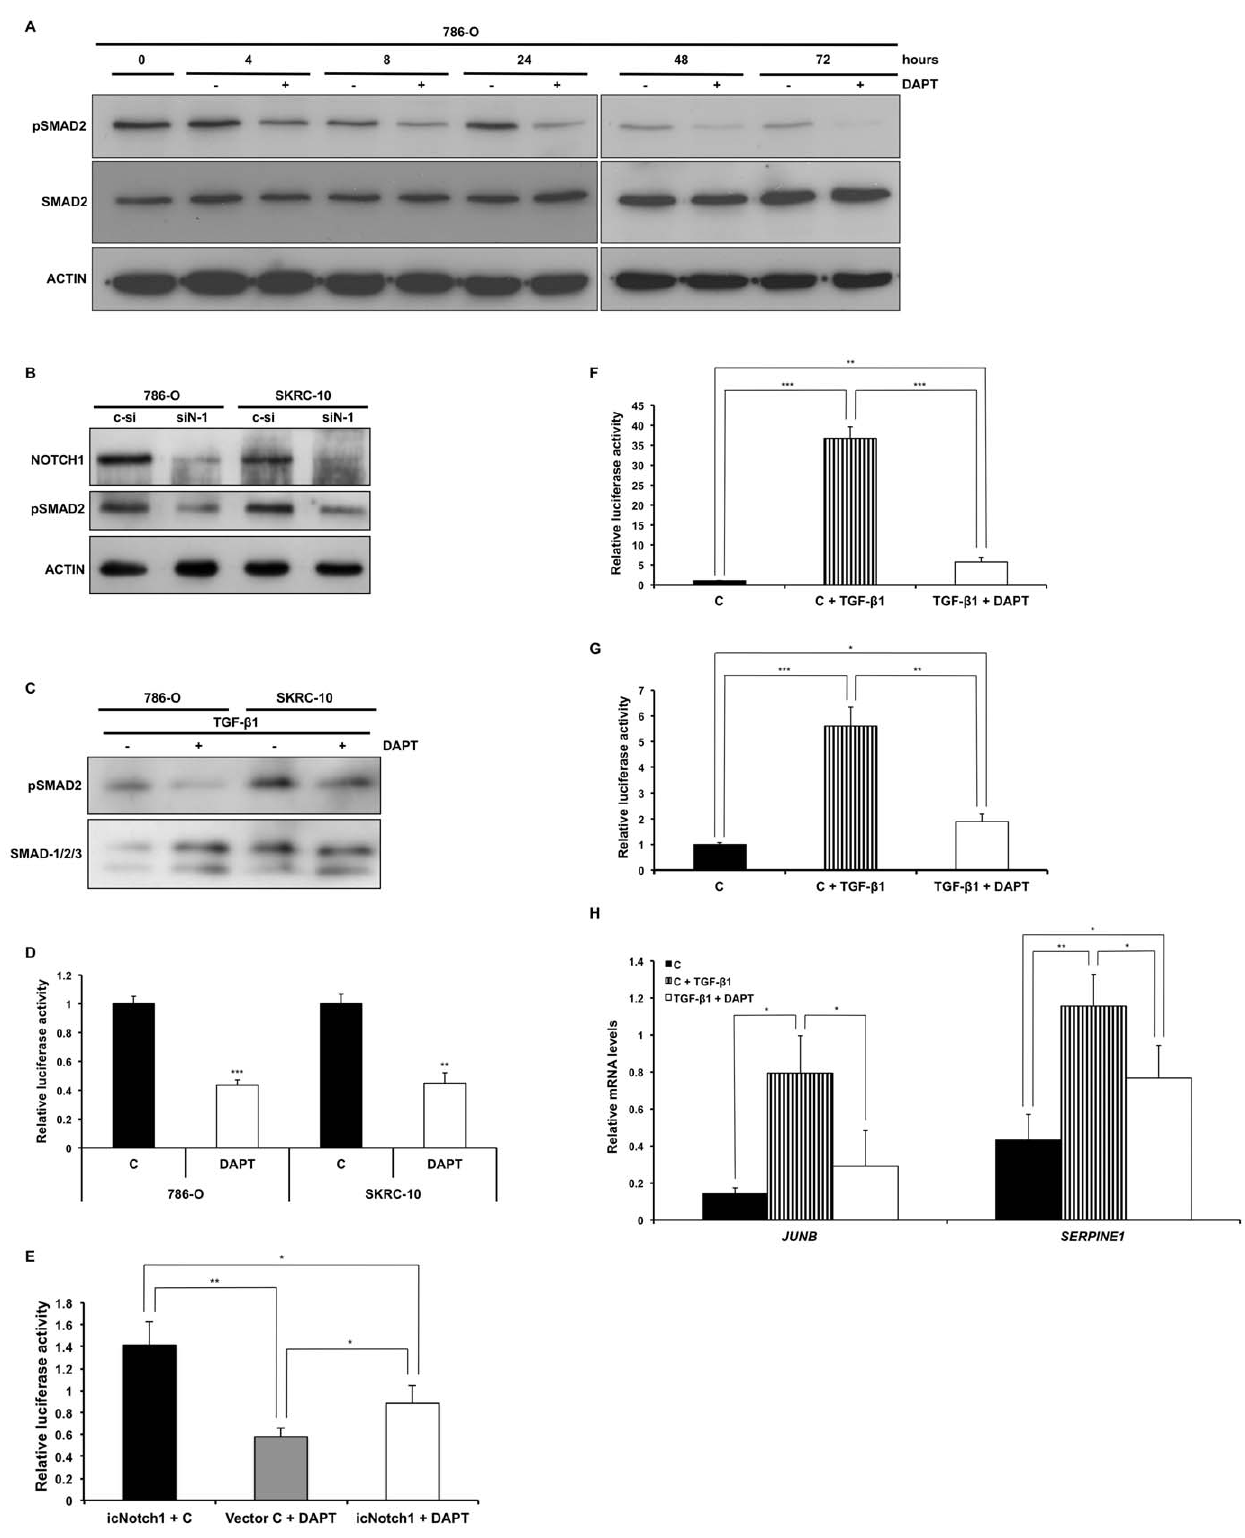
Figure 4. Notch inhibition alters endogenous and TGF- b 1 induced activation of the TGF- b signaling pathway. ( A ) Immunoblotting using pSMAD2 antibody and SMAD2 antibody, of cell lysates from 786-O cells stimulated with vehicle control ( 2 ) or DAPT ( + ) for the indicated time points. ( B ) Immunoblotting using Notch1 antibody and pSMAD2 antibody of cell lysates from 786-O and SKRC-10 cells transfected with control siRNA (c-si) or siRNA against Notch1 (siN-1). Cells were harvested after 24 h of transfection. ( C ) Western blot analysis, using pSMAD2 antibody and SMAD-1/ 2/3 antibody of cell lysates from 786-O and SKRC-10 cells stimulated with 0.25 ng/ml TGF- b 1 and vehicle ( 2 ) or 0.25 ng/ml TGF- b 1 and DAPT ( + ) for 4 h. ( D ) 786-O and SKRC-10 cells transfected with the ( CAGA ) 12 - Luc reporter construct and treated with vehicle control (c) or DAPT for 24 h and